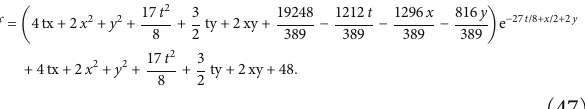
Figure 10: Two types of interactions between two lumps and a stripe in Equation (1). (a) Bright-type interaction solution with u c = − 1 . (b) Dark-type interaction solution with u 0 = − 1 and c = 1